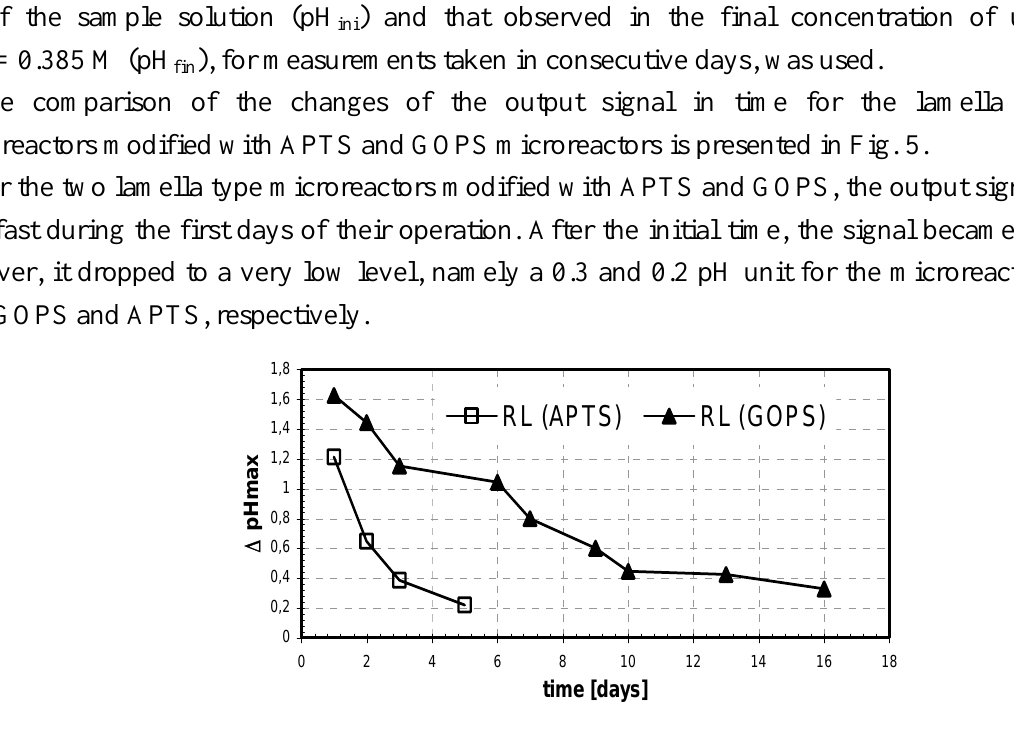
) in time for two lamella type silicon microreactors max